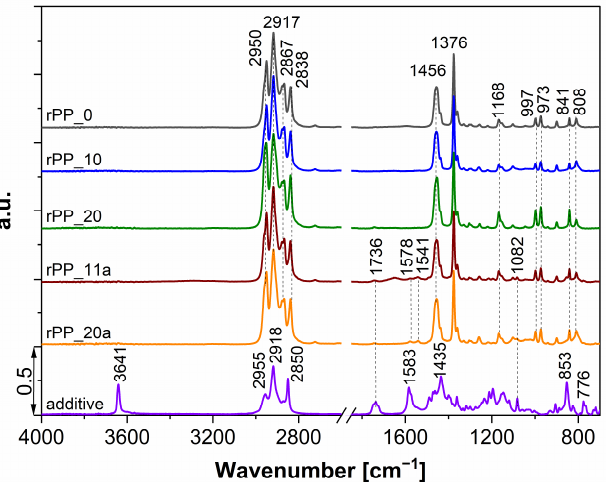
Figure 1. ATR-IR spectra of virgin PP, recycled with (rPP_a) and without (rPP) additive.